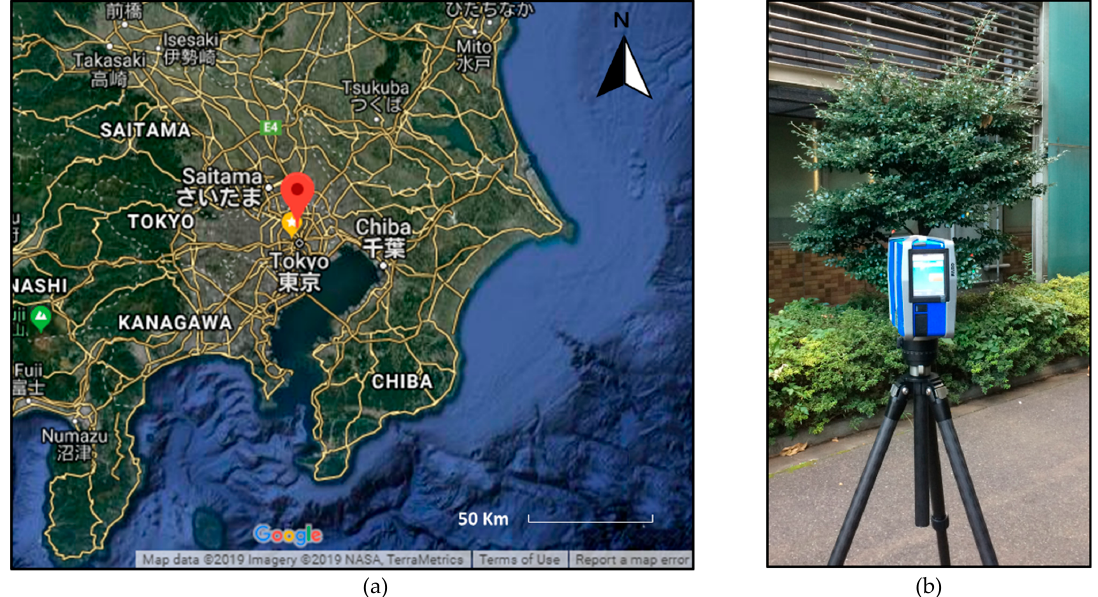
Figure 1. ( a ) Location of study area (red hot spot; source: © 2019 Imagery, © 2019 NASA, TerraMetrics). ( b ) Set-up of terrestrial